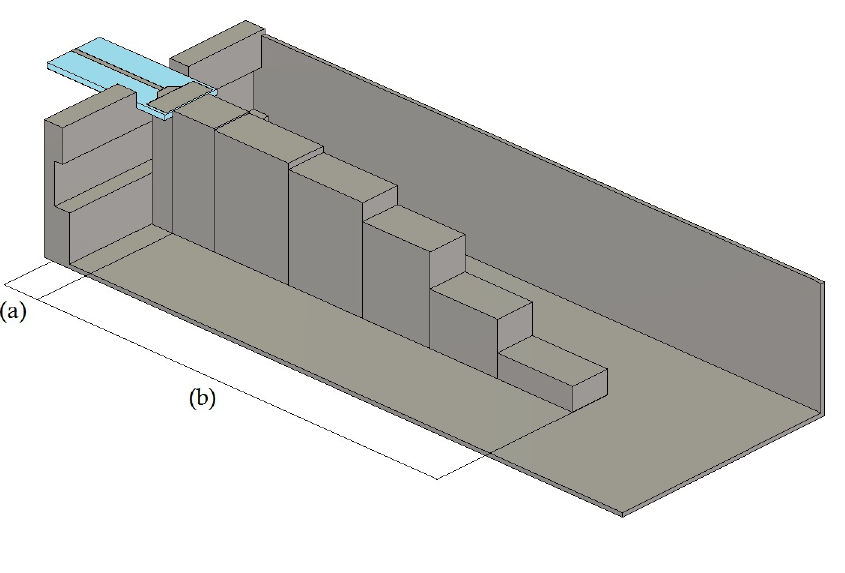
Figure 4. Final geometry, with launcher ( a ) and matching impedance ( b )